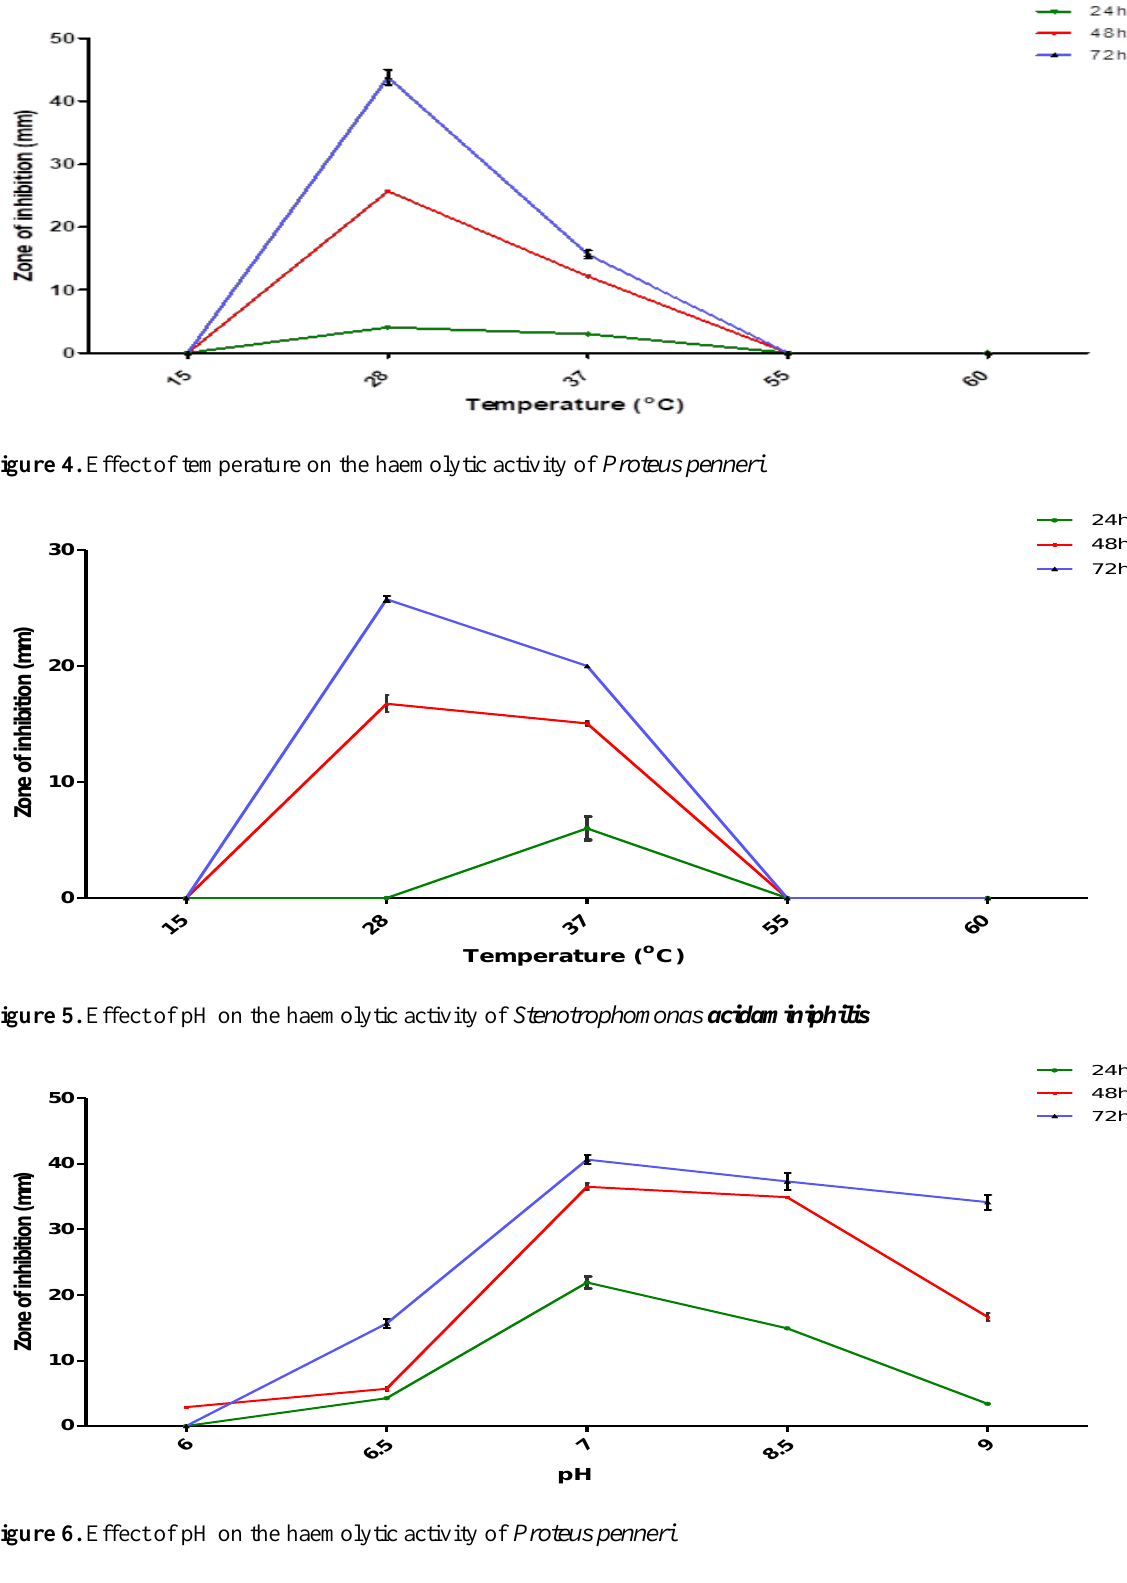
Figure 3. Effect of temperature on haemolytic activity of Bacillus cereus